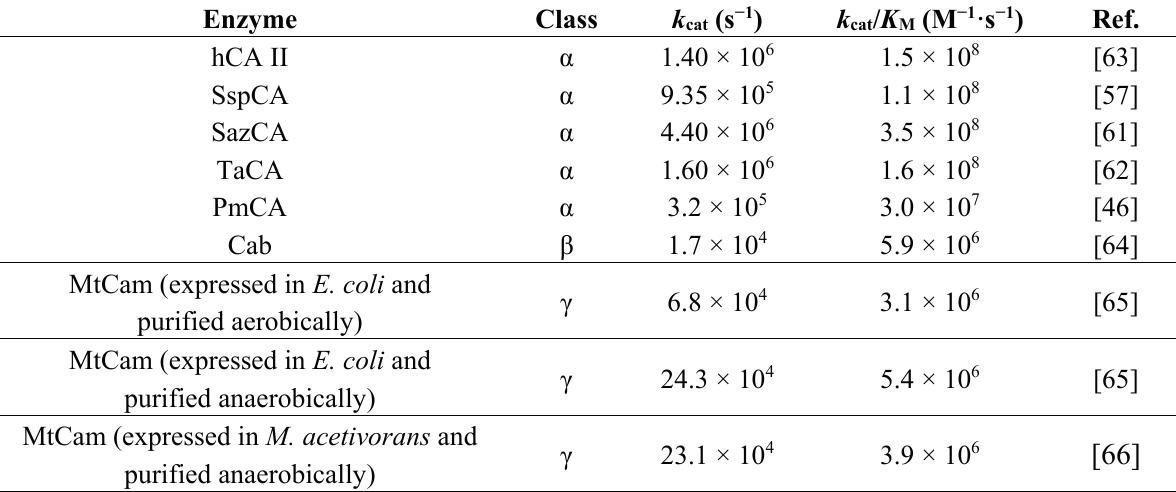
Table 1. Kinetic parameters for the CO 2 hydration reaction catalyzed by thermostable CAs. Data on hCA II have been added for